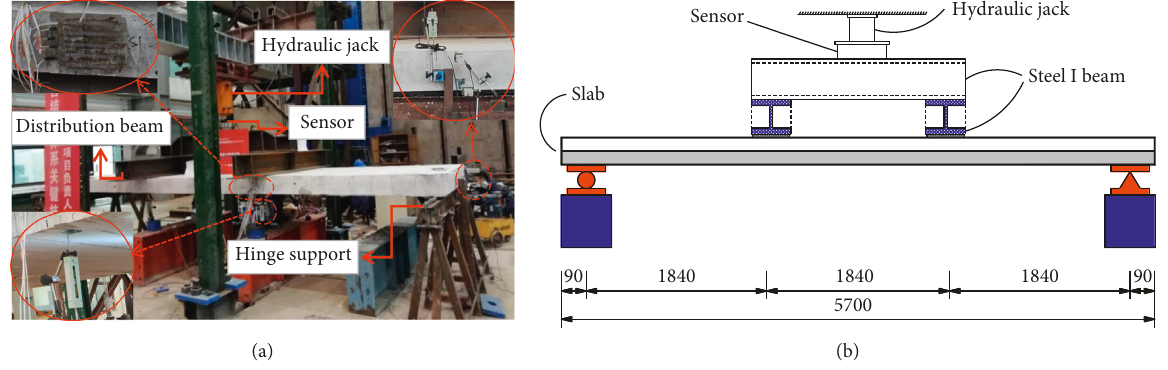
Figure 5: Loading test: (a) loading test site; (b) test setup.